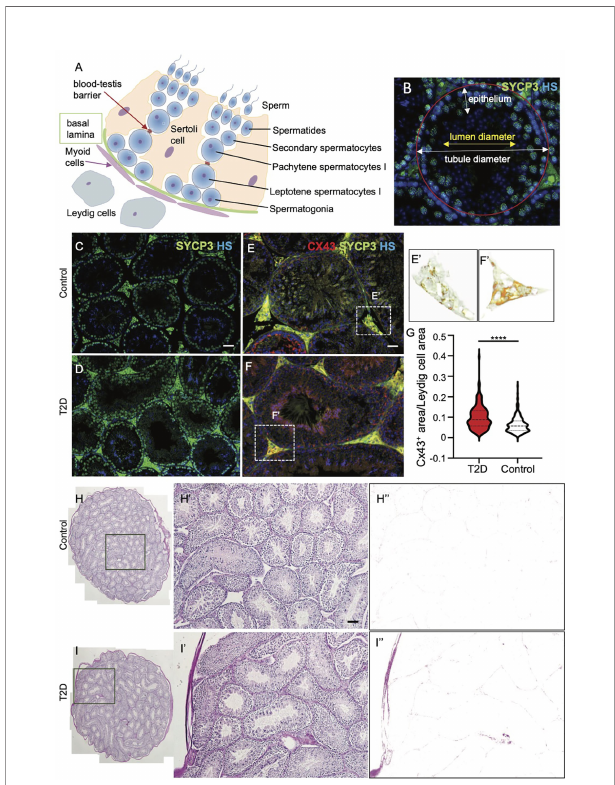
FIGURE 5 | Morphological and expressional changes in the testes of T2D males. (A) Schematic cross-section through a testicular tubule, showing germ cells at different stages of spermatogenesis embedded within the somatic Sertoli cells. Leydig cells are present in the interstitium. The blood-testis barrier facilitates the migration of spermatocytes in addition to the maintenance of the microenvironment. (B) Morphological evaluation of seminiferous tubules included the measurements of tubule diameter and epithelium thickness for different spermatogenesis stages. (C, D) Representative images of cross sections of control and T2D testes after immunolabeling of meiotic marker SYCP3, an axial element of the synaptonemal complex, show the germinal epithelium lining seminiferous tubules at different stages of spermatogenesis. Nuclei are counterstained with Hoechst 33342 (HS, blue). (E – G) Immunolabeling of tissue sections shows increased Cx43 expression in the interstitial tissue of the testes of T2D males compared to controls. (E ’ , F ’ ) Delineated Cx43 + area in the testis sections by ImageJ program. A relative quanti fi cation of staining determined as a ratio of Cx43 + areas per the total Leydig cell areas by ImageJ. Stacked violin plot shows the differential expression of Cx43 in control and T2D. Data are presented as the mean ± SEM (n = 6 controls/271 Leydig cell areas, and 6 T2D/198 Leydig cell areas). Differences between groups were tested by t -test (GraphPad Prism 7.0). ****P < 0.0001. Nuclei are counterstained with Hoechst 33342 (blue). (H – I ’ ) Representative images of PAS staining of the control and T2D testes show increased advanced glycation end-products in the interstitial tissue of the testes from T2D males. (H ” , I ” ) Delineated PAS + area in the testes by ImageJ. Scale bars, 50